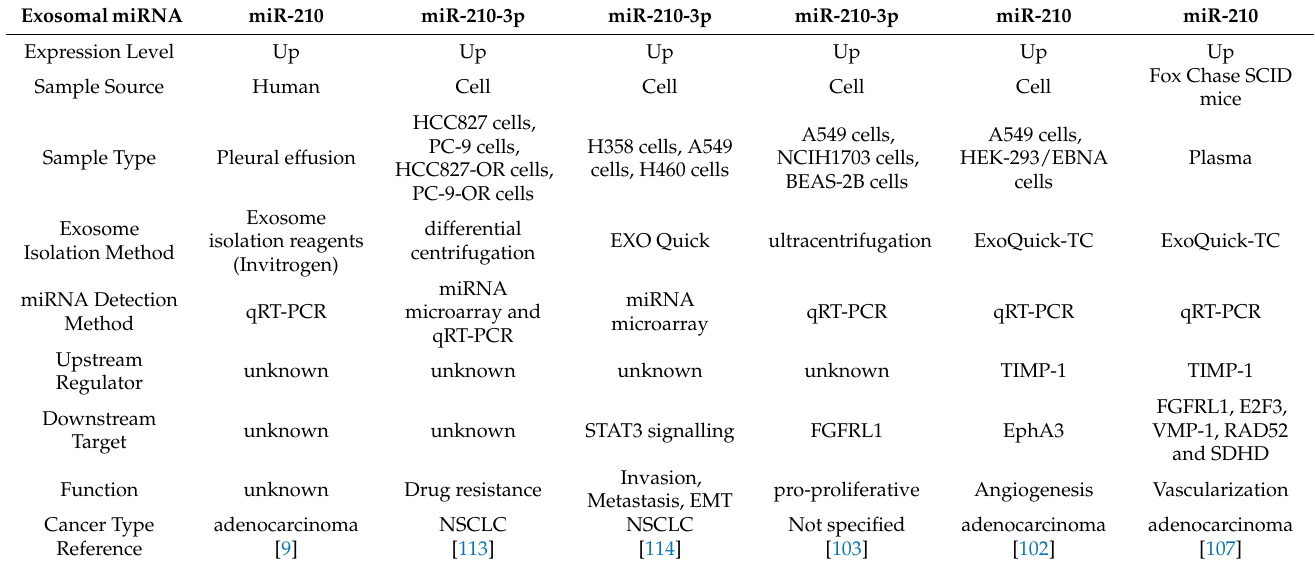
Table 1. MiR-210 expression in human, cell, and mouse